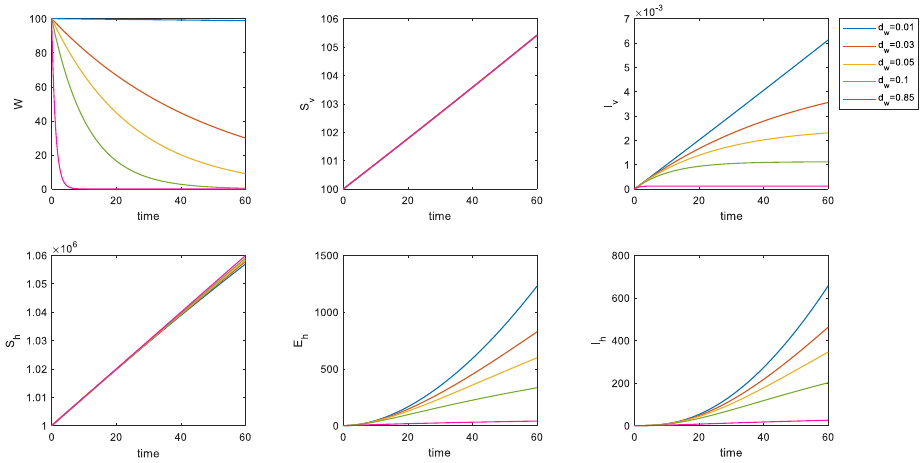
Figure 5. Changes in the numbers of W , S h , E h , and I h with different d w in model 2.